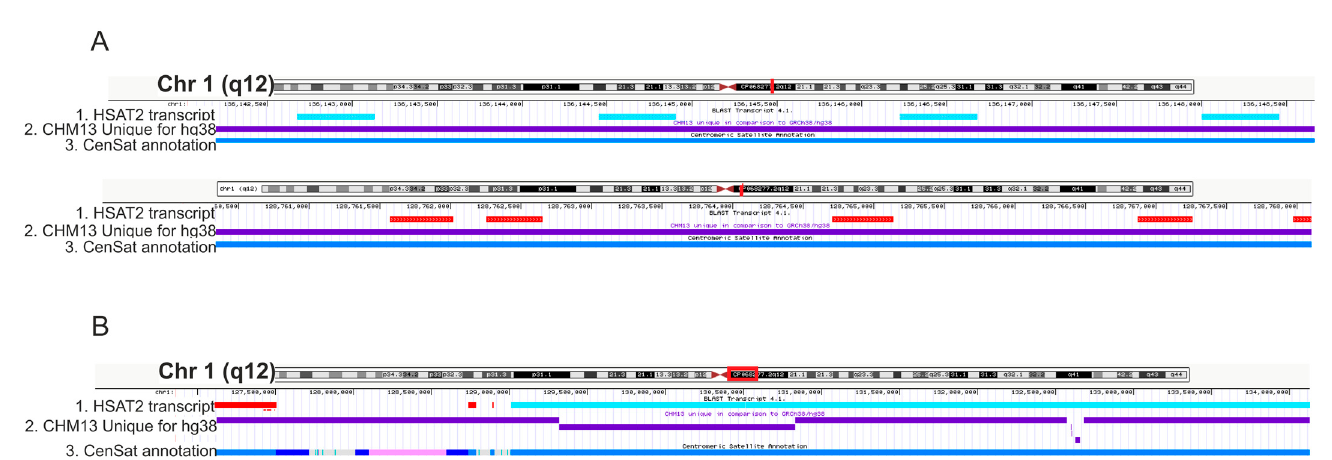
Figure 2. “+” and “ − ” orientation of the cloned transcript hits arrays. ( A ) Visualization of 2 fragments of chromosome 1 pericentromeric region (red lines on chromosome 1 ideograms) at high magnification. Turquoise rectangles in track 1—HSAT2 transcript arrays in the “ − “ (G-rich) strand. Red rectangles in track 1—HSAT2 transcript arrays in the “+” (C-rich) strand. ( B ) Chromosome 1 pericentromeric region at low magnification (red frame on chromosome 1 ideogram). Track 1 shows hits in the opposite direction (red and turquoise rectangles) that compose spatially separated tandemly organized arrays. Within each array, repeating units of the transcript are positioned in a head ‐ to ‐ tail manner. Track 2 in A,B—the track of sequences (purple rectangles) unique to T2T ‐ CHM13 as compared to GRCh38/hg38; track 3—the track of satellite annotation. The colors in the third track are shown according to the Centromeric Satellite Annotation colors given in UCSC Ge ‐